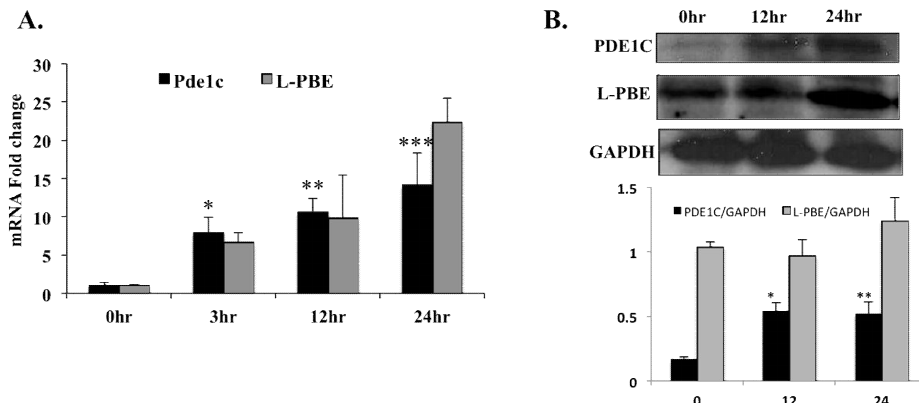
Figure 2. In WT mice, injection with PPARα agonist Wy-14,643 induced Pde1C mRNA and PDE1C protein expression in the heart: WT mice were injected with 250 mg/kg body weight of Wy-14,643 via i.p. for 3-, 12-, and 24-h. At each time point mouse hearts were harvested and total RNA as well as total protein from heart lysates were analyzed by RT-qPCR and Western blot, respectively. ( A ) Cardiac Pde1C mRNA levels in Wy-14,643-treated mice increase by 8-, 11-, and 14-fold at 3-, 12-, and 24-h, respectively. Similarly, cardiac mRNA levels of positive control L-pbe increase upon Wy-14,643 injection of the mice. ( B ) Total protein from hearts was analyzed by Western blot using anti-PDE1C antibody. GAPDH was used as loading control. PDE1C and L-PBE protein bands were quantified as described in section 4 and normalized to GAPDH levels. PDE1C protein levels increased upon Wy-14,643 treatment. Data was analyzed by t -test, n = 4–6 per group, * p < 0.05, ** p < 0.01, *** p < 0.001.